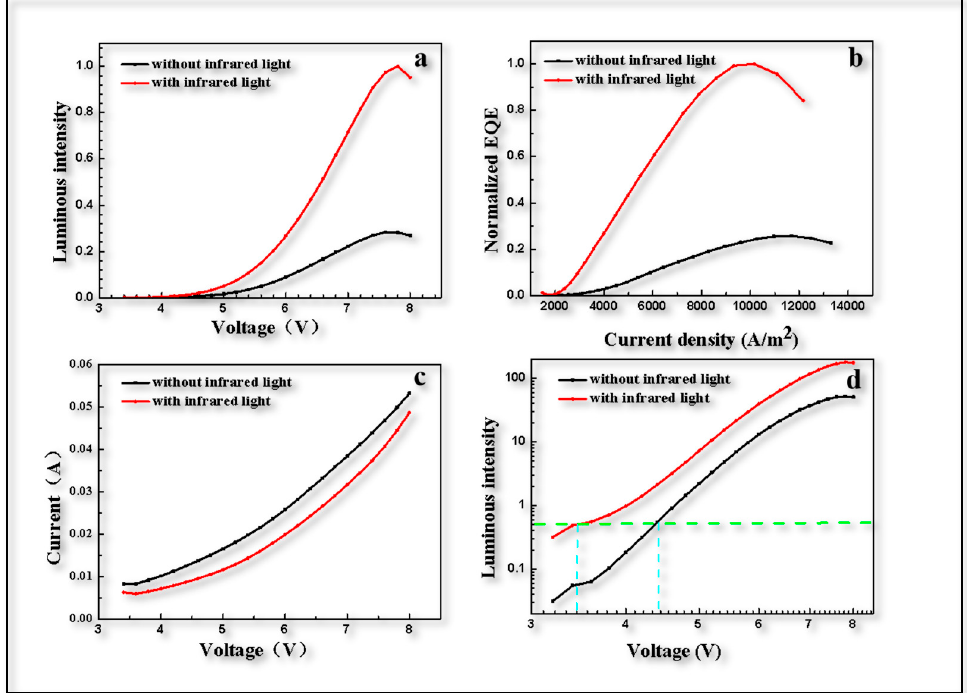
Figure 6. Photoelectric performance test of upconversion device. ( a ) Value of green light emission intensity of device with voltage change. ( b ) Normalized EQE varies with current density. ( c ) I-V curve of current with voltage. ( d ) Change of switching on voltage of 530 nm green light.